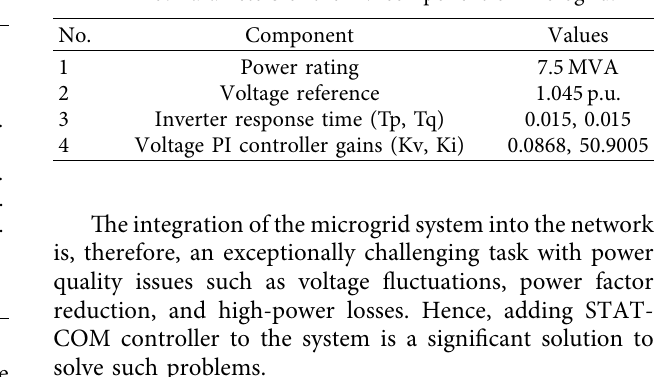
Figure 14: Reactive power: (a) with PI controller and (b) with fuzzy-PI controller. Table 4: Value of the wind component in the microgrid system. Table 5: Parameters of the PV component of